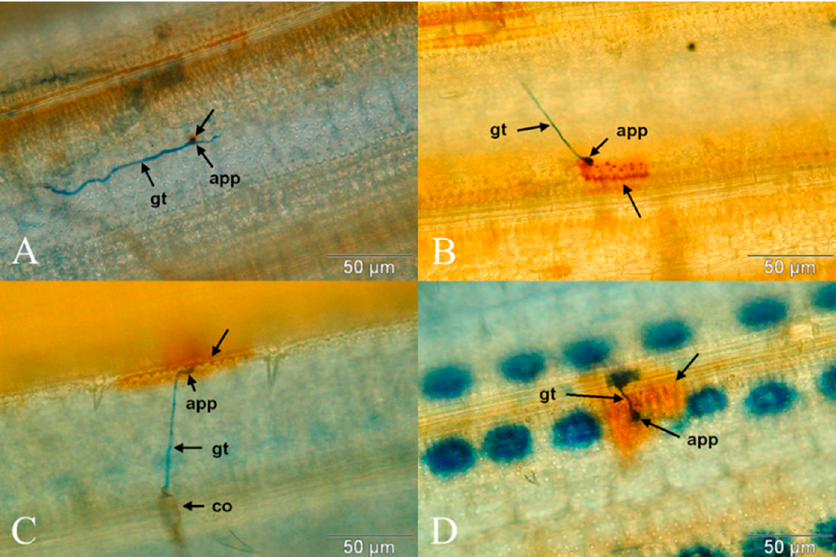
Figure 2. Details of infection biology and defence responses of rice cv. MTL189 infected by Bipolaris oryzae isolate B5 (compatible interaction). DAB staining showing H 2 O 2 accumulation in relation to B. oryzae . ( A ) Penetration attempt resulting in hydrogen peroxide accumulation under papilla (arrow) at 12 hai. ( B ) Penetration resulting in hydrogen peroxide accumulation under papilla at 16 hai. Arrow shows FEC. ( C ) Penetration resulting in hydrogen peroxide accumulation in FEC at 20 hai. Arrow shows FEC. ( D ) Penetration resulting in hydrogen peroxide accumulation in FEC at 24 hai. Arrow shows FEC. Abbreviations as in Figure 1.